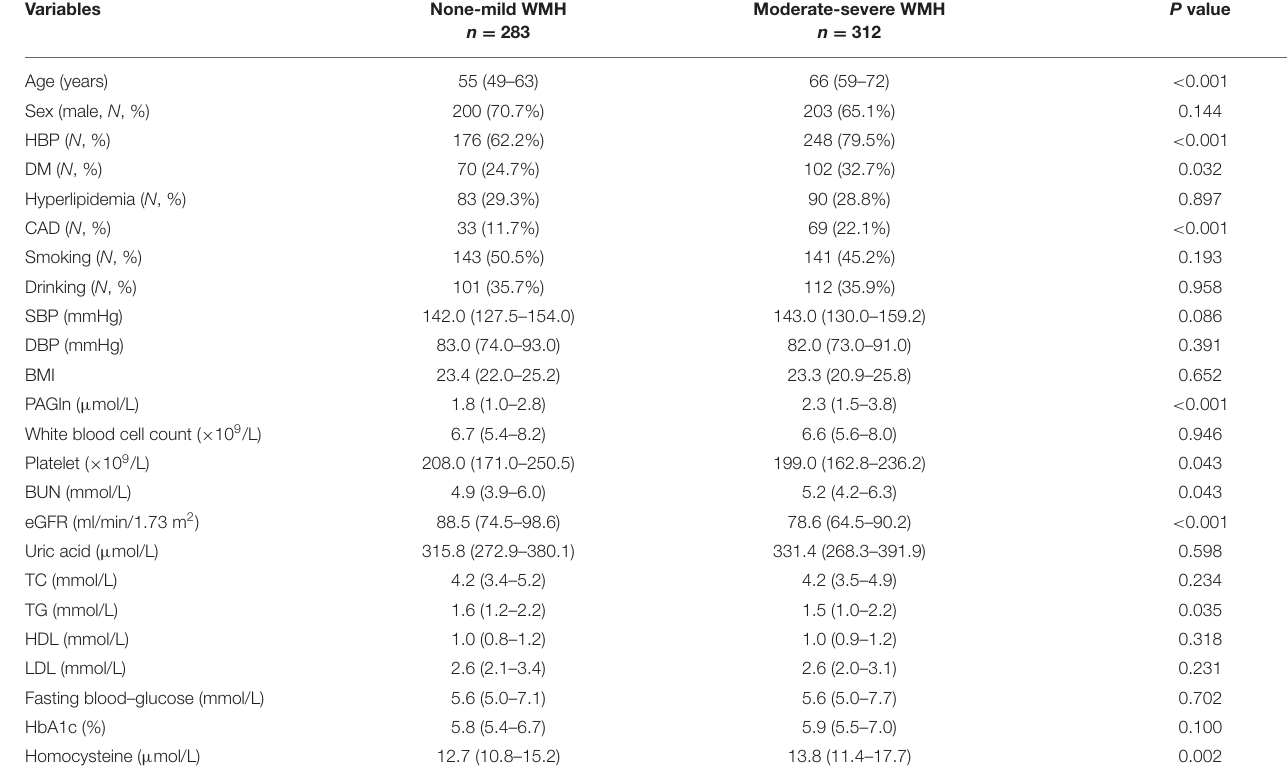
TABLE 2 | Baseline characteristics of all patients according to the degree of overall WMH.